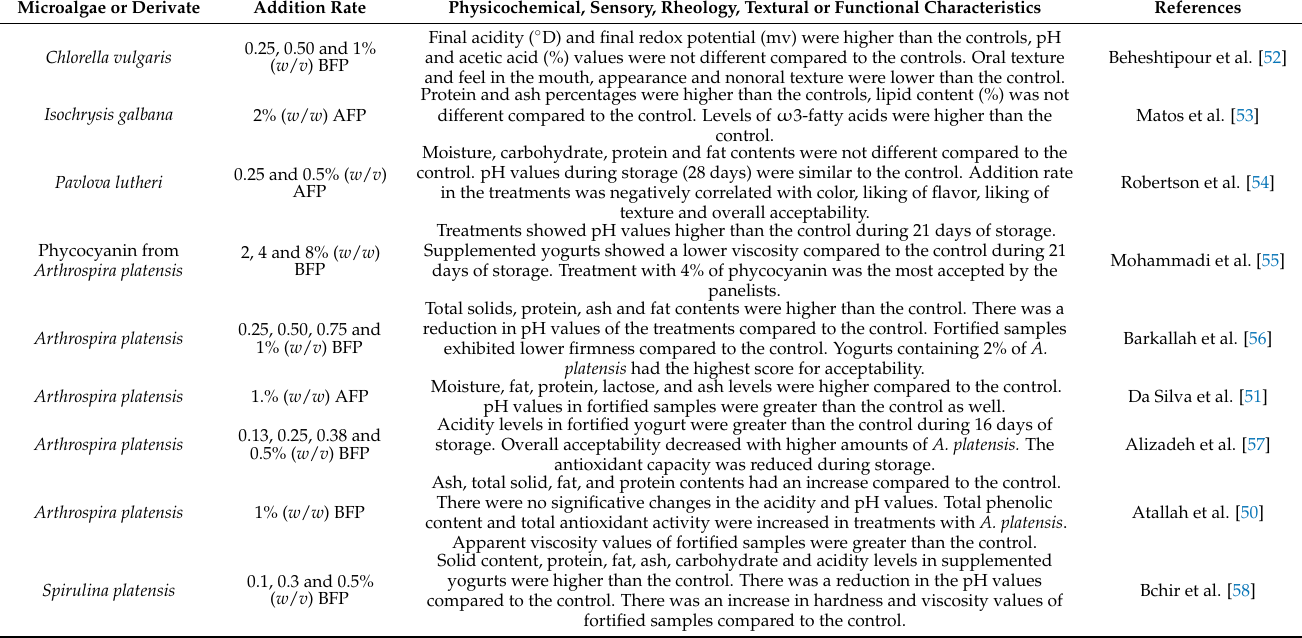
Table 2. Studies on the application of microalgal biomass or derivates in yogurt. BFP—before the fermentation process; AFP—after the fermentation